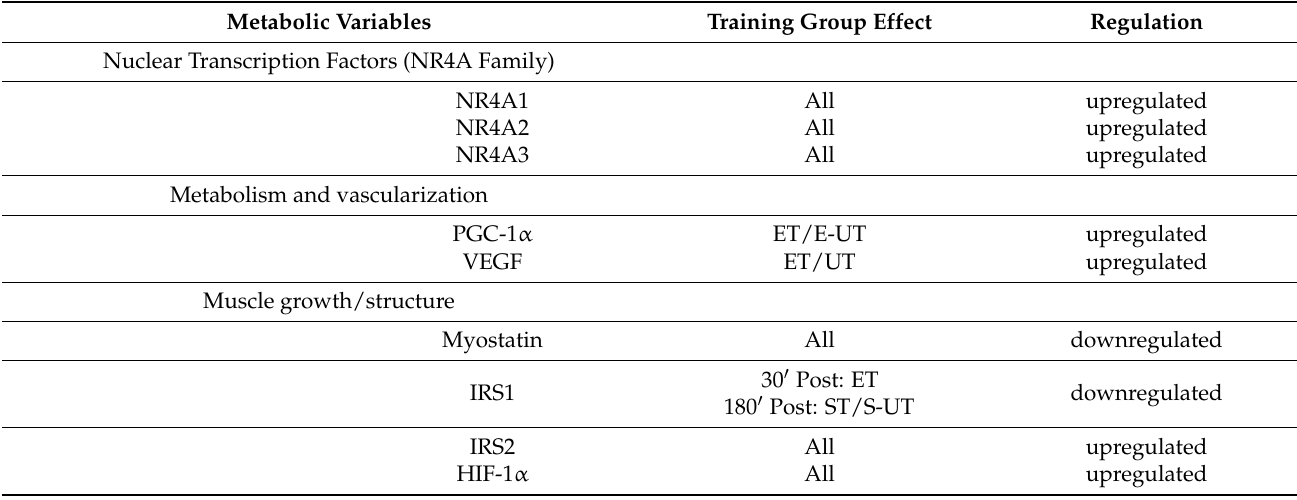
Table 2. Overview of the effect of the acute exercise test on the exercise-related genes subdivided into the NR4A family, metabolism and vascularization, and muscle